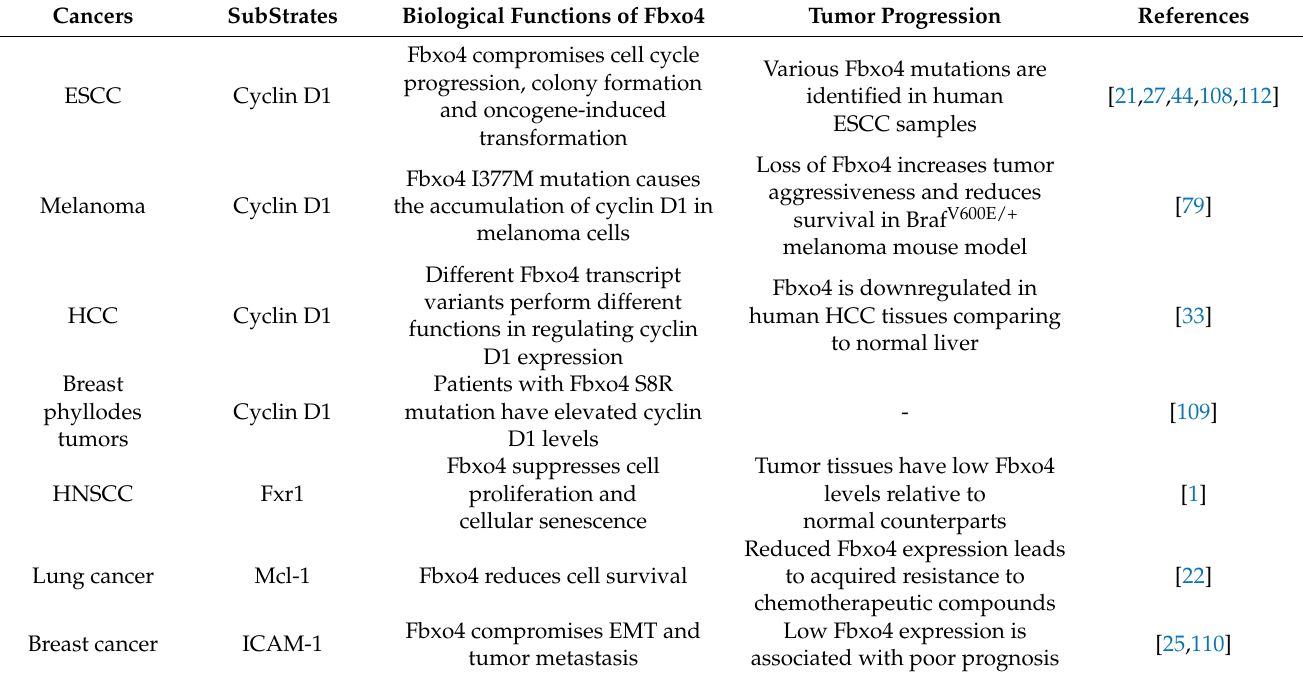
Table 1. The clinicopathological importance of Fbxo4 in human